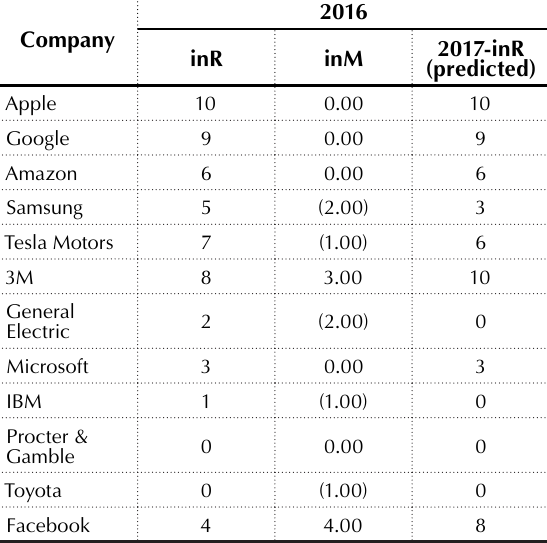
Table 5. Predicted normalized Innovation Ranking for the top 12 innovators in 2017